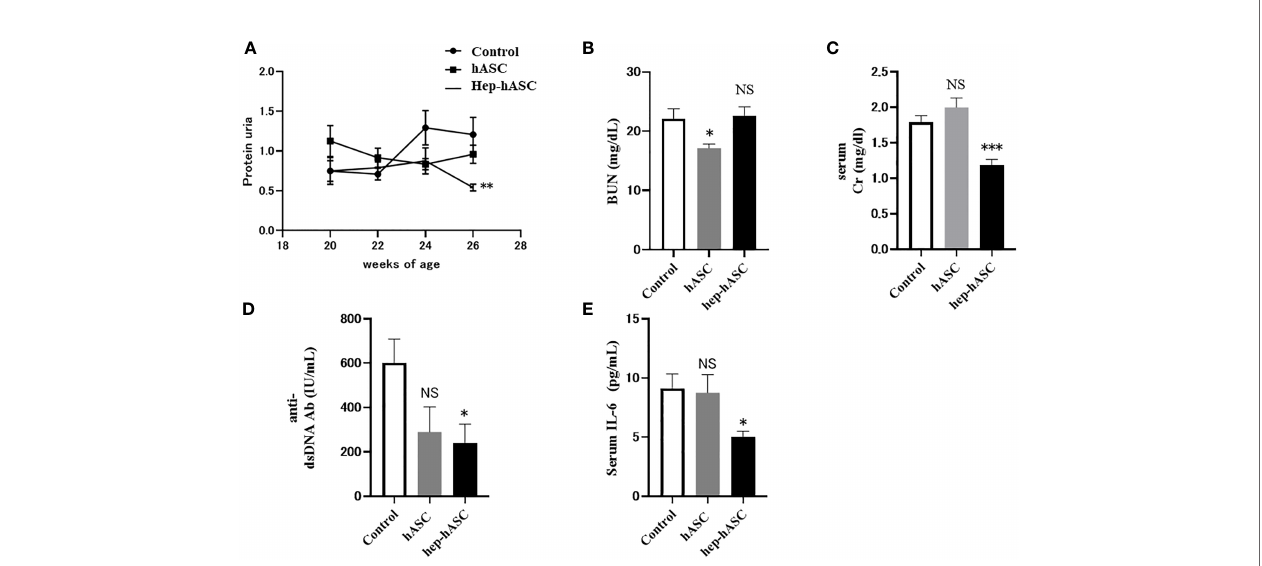
FIGURE 2 | Effect of hep-hASC transplantation on clinical and serological parameters in NZB/W F1 mice. The effect of saline (control), hASC, and hep-hASC on (A) urine protein score, (B) serum blood urea nitrogen level, (C) serum creatinine level, (D) serum anti-dsDNA antibody titer, (E) serum IL-6 levels in NZB/W F1 mice. Data expressed as mean ± SEM (N=12 mice per group). *P < 0.05. **P < 0.01. ***P < 0.001. NS, not signi fi cant vs. control group. ASCs, adipose-derived mesenchymal stem